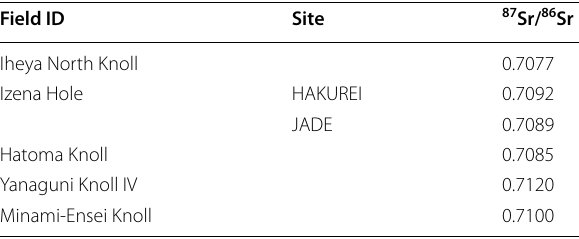
Table 2 End‑members of Sr isotope ratios in hydrothermal